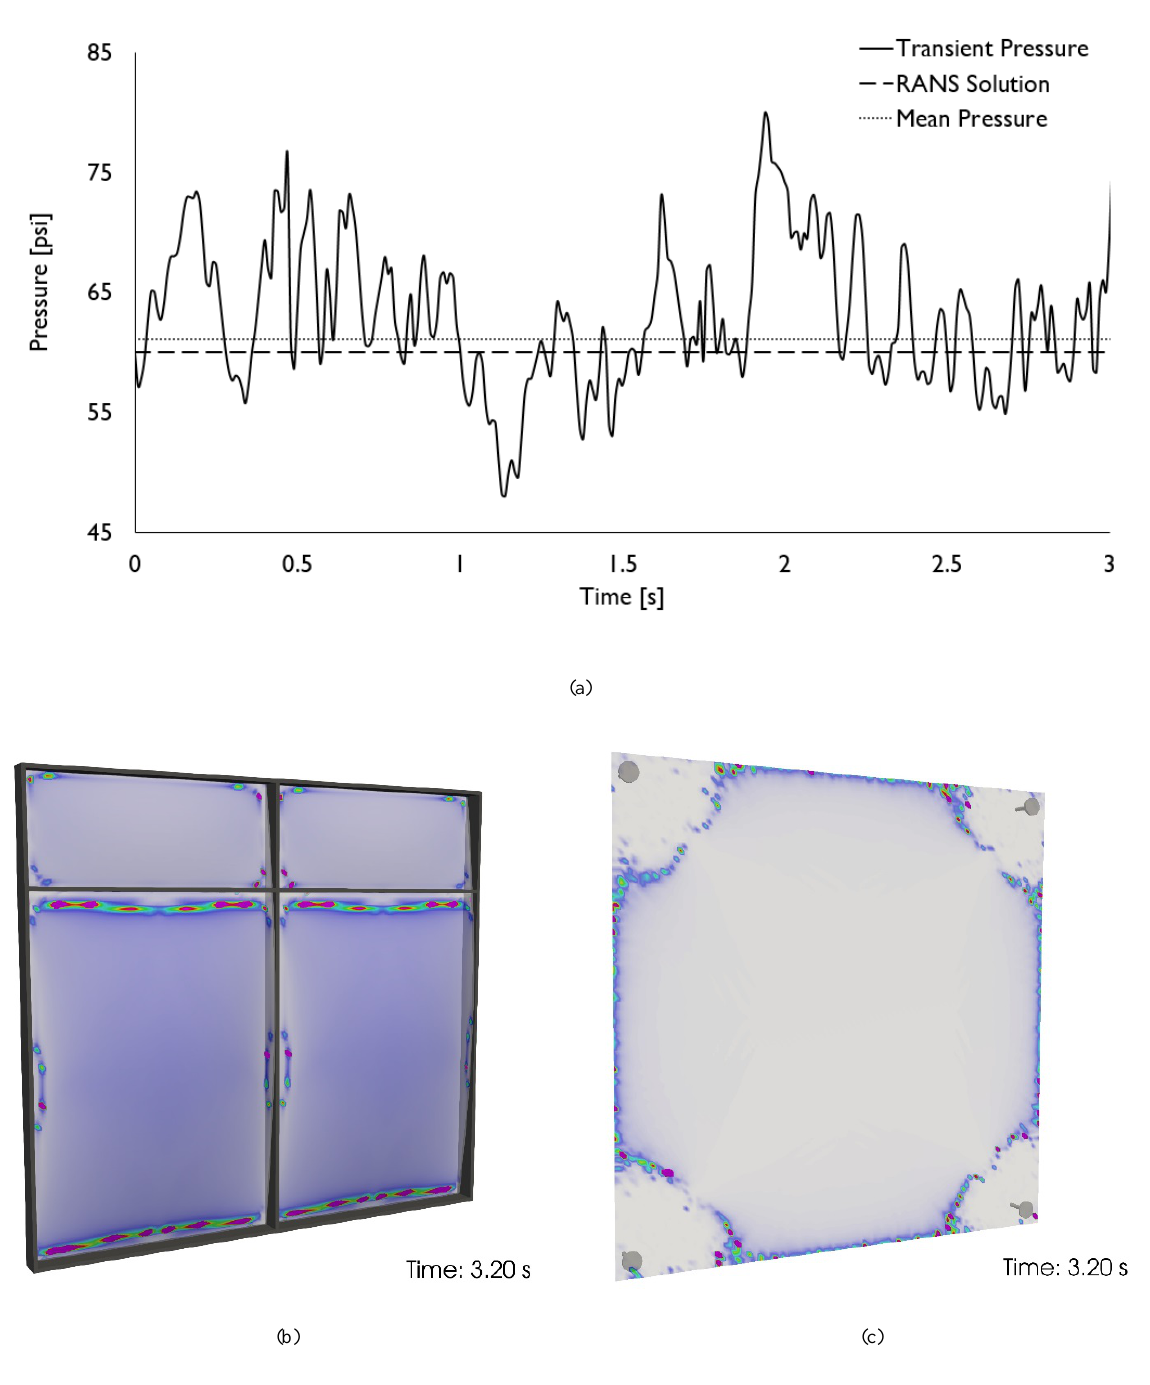
Fig. 11 High-fidelity physics based (HFPB) modeling two glazing designs. The negative-pressure (suction) load history (a) was used as the input loading function for the HFPB calculations for the standard glazed curtain wall cassette (b) and the point-supported glass model (c). The time step color fringes show ‘stress-biaxiality’ within the glass (i.e., the ratio of the minimum and maximum principal stresses). This metric is used as a key input parameter ASTM. 2016. E1300-16